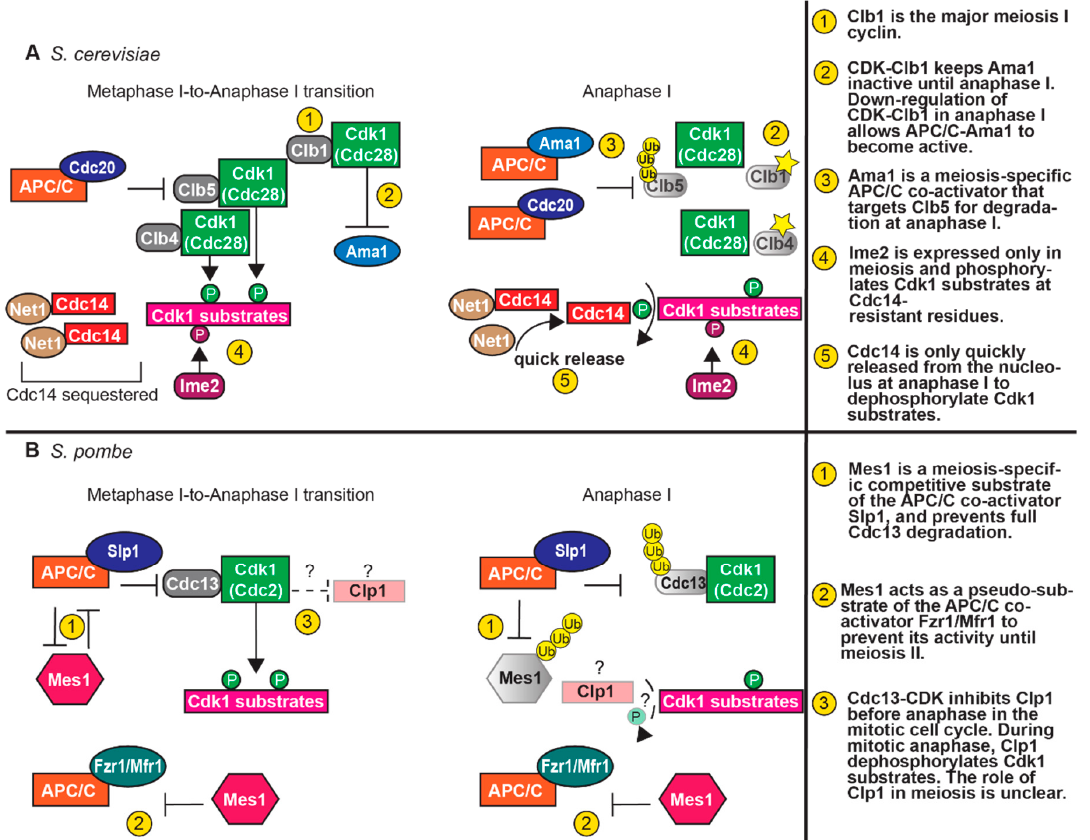
Figure 2. Regulation of CDK activity in meiosis I. ( A ) At the metaphase I-to-anaphase. I transition in budding yeast meiosis Cdc14 is held inactive by Net1. APC / C-Cdc20 targets Clb5 for degradation while the APC / C co-activator Ama1 is inhibited by CDK-Clb1. Ime2 phosphorylates a subset of Cdk1 substrates. At anaphase I, Ama1 becomes active and APC / C-Ama1 targets Clb5 for further degradation. Clb1 and Clb4 are likely post-translationally modified (denoted with star) to downregulate CDK activity. Cdc14 activation is promoted by only the FEAR pathway, causing a partial but not full dephosphorylation of CDK substrates. Cdc14 reverses CDK, but not Ime2, phosphorylation on substrates. Combined, this regulation leads to a decline in CDK activity. ( B ) In fission yeast meiosis, Mes1 inhibits the APC / C. Mes1 is a competitive substrate of the APC / C co-activator Slp1 (Cdc20) and a pseudo-substrate of the co-activator Fzr1 / Mfr1. Mes1 prevents full degradation of Cdc13 during meiosis I, thus allowing for retention of some CDK activity. Progression into anaphase I requires APC / C ubiquitination and proteasomal degradation of Mes1. Mes1 inhibits Fzr1 / Mfr1 until meiosis II. The role of Clp1 (Cdc14) in meiosis is unclear, as deletion of clp1 has no e ff ect on the timing of meiosis, but has a minor e ff ect on the formation of four-spore